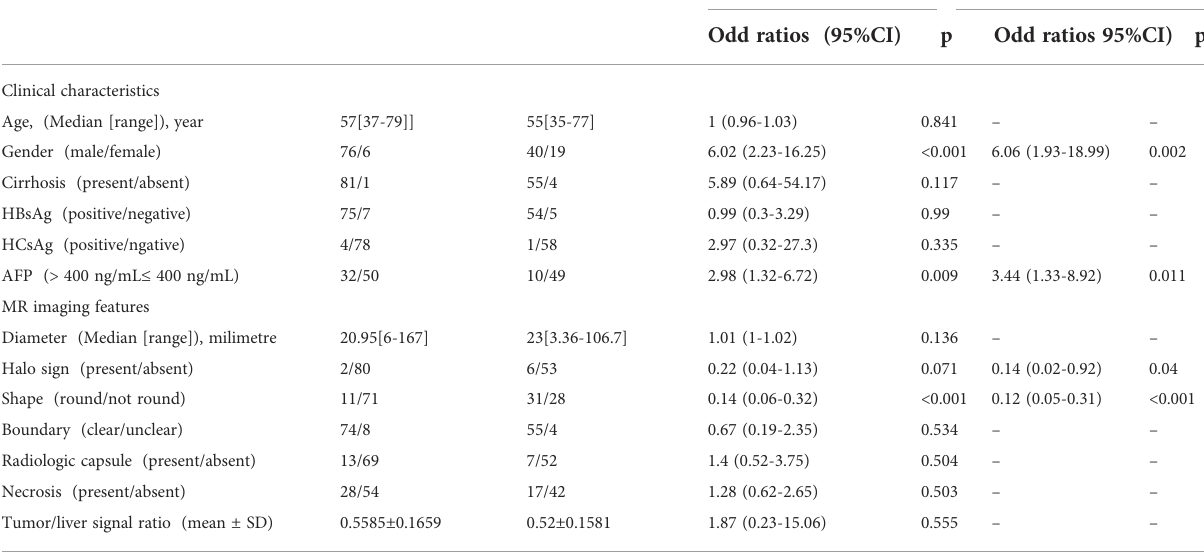
TABLE 1 Comparisons of clinicoradiological characteristics in MVI (+) and MVI (-) patients. Clinicoradiological characteristics MVI (+) (N=82) MVI (-)